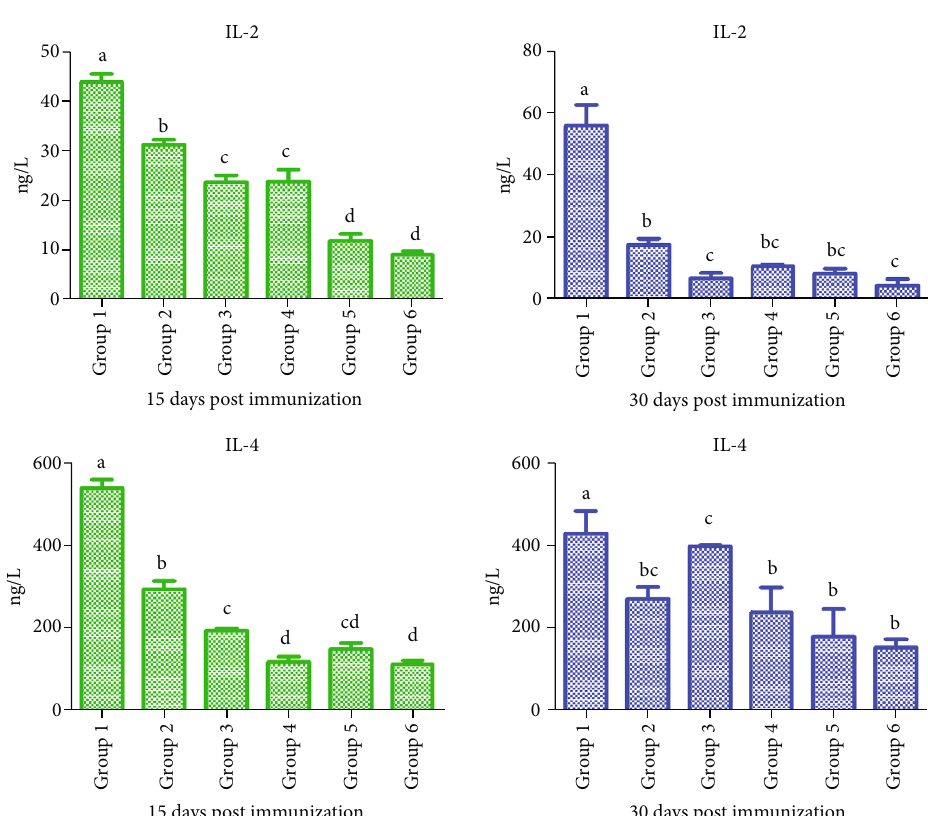
Figure 4: The levels of IL-2 and IL-4 in rabbits from Experiment B were assessed by ELISA at 15 and 30 days